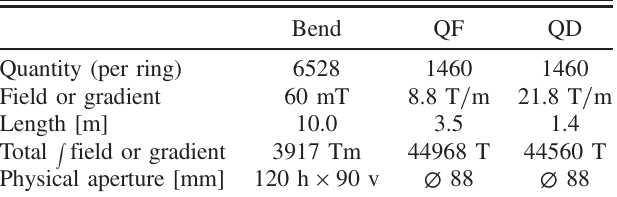
TABLE I. Main requirements of FCC-ee arc dipoles and quadrupoles, at 175 GeV per